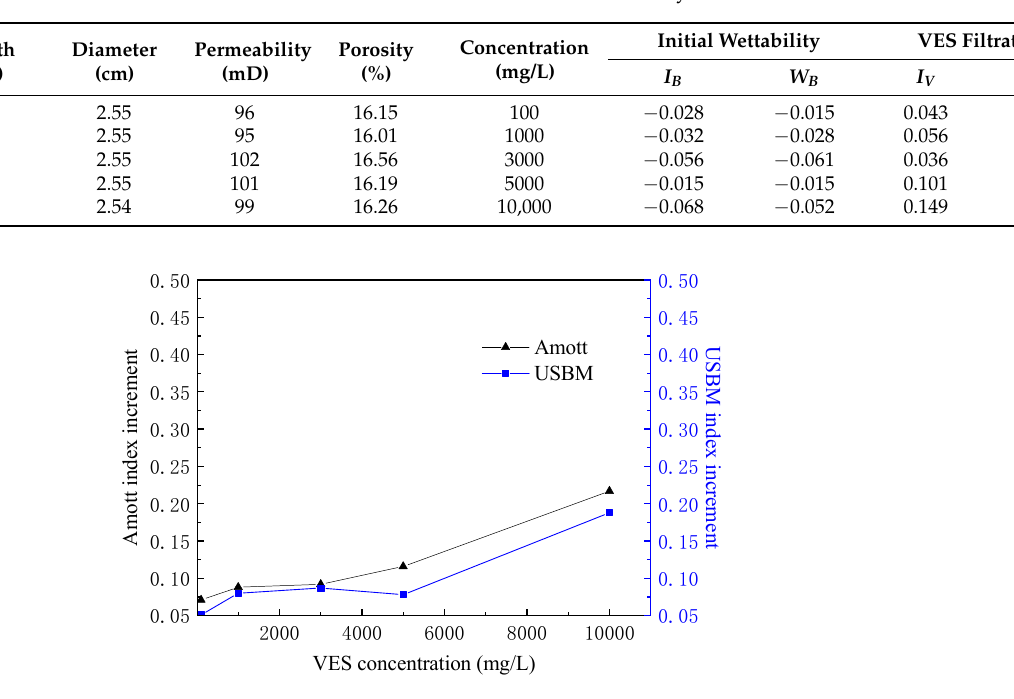
Table 4. Effect of VES concentration on wettability.